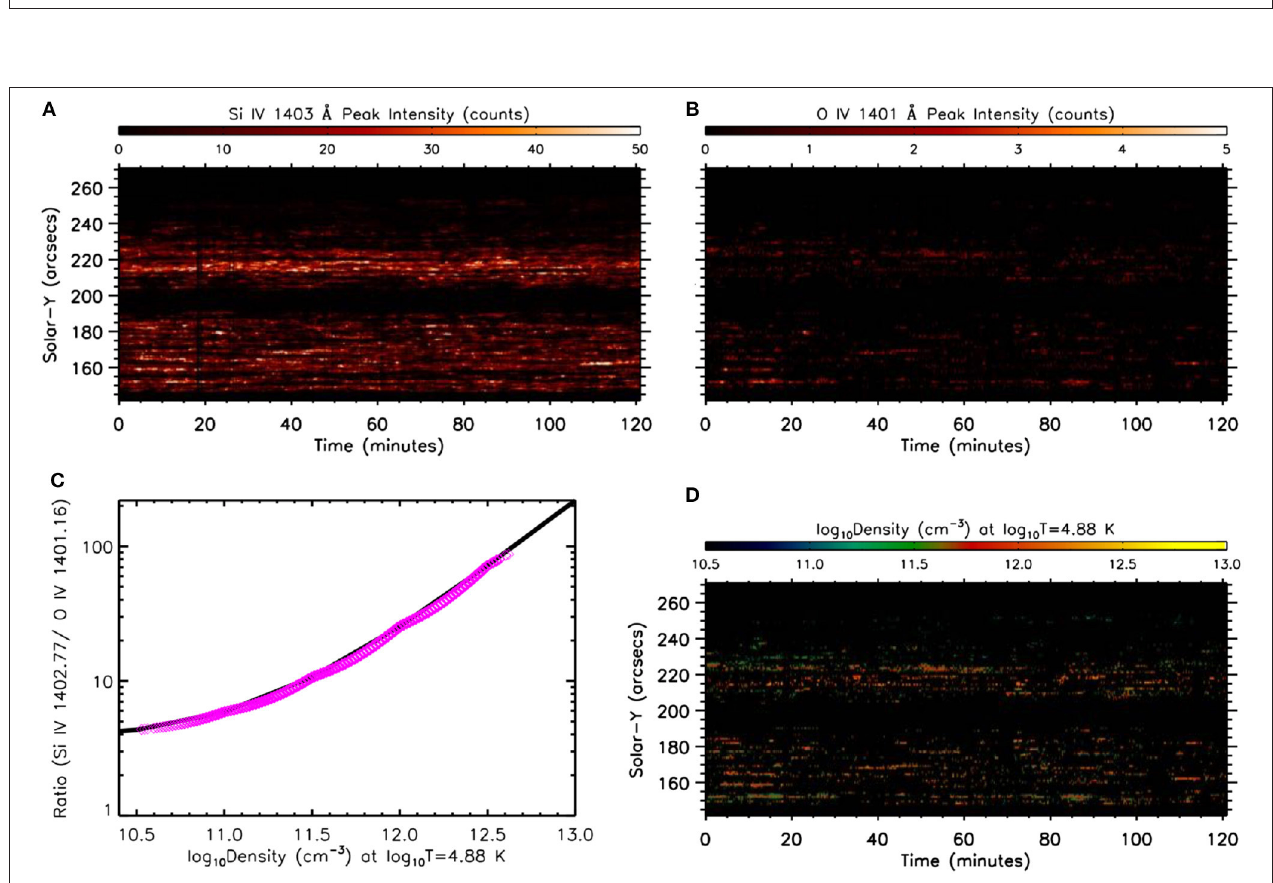
FIGURE 11 | (A,B) Time-sequence maps of peak intensity of the SiIV(1403Å) and OIV(1401Å) line. (C) Theoretical SiIV(1403) / OIV(1401) ratio density curve in solid black and the estimated values of the density in magenta corresponding to the observed ratios. (D) Time-sequence map of the estimated density.